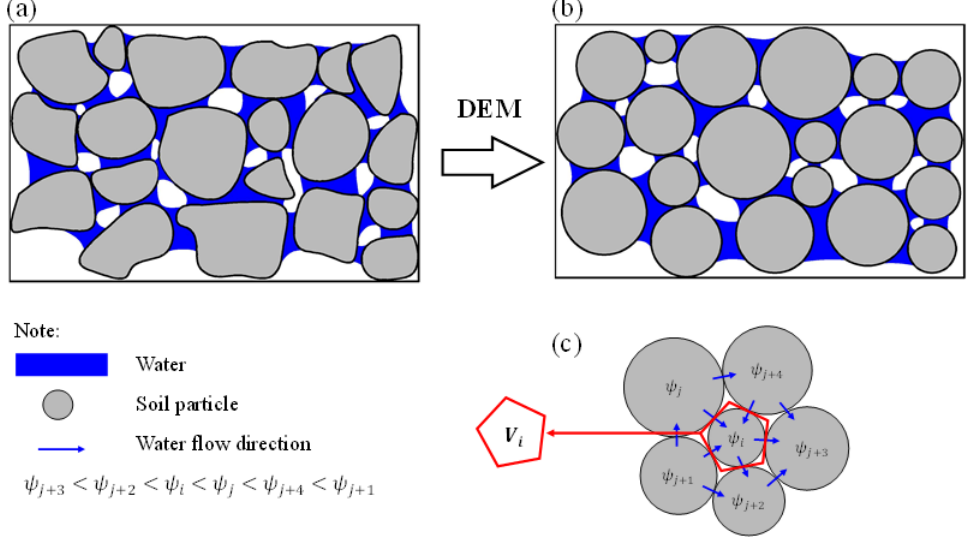
Figure 2. ( a ) The arrangement of particles and water distribution in soil; ( b ) equivalent DEM model; and ( c ) a schematic diagram illustrating water migration between particles.